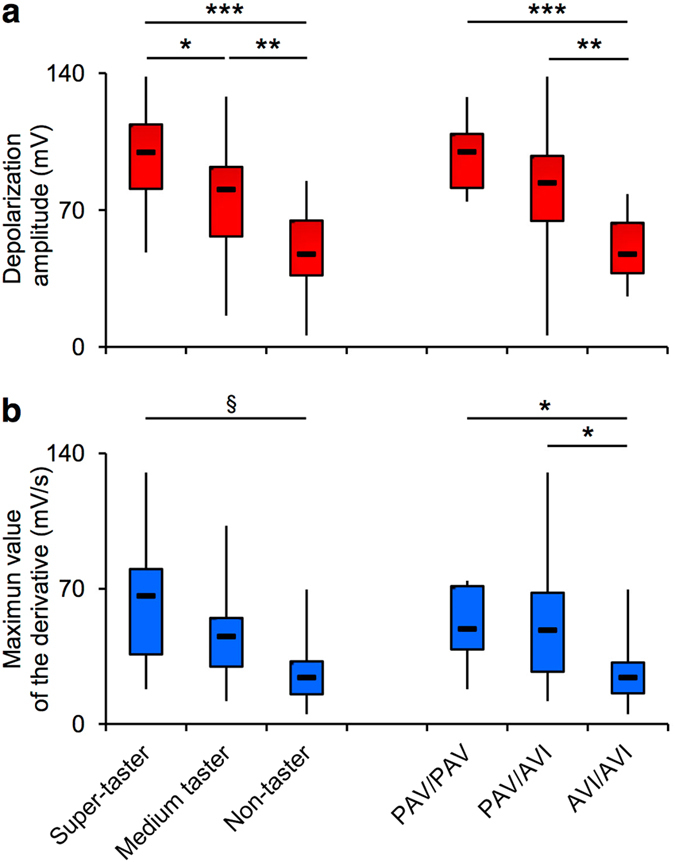
Relationship between the parameters describing the waveform of signals and the PROP taster status or TAS2R38 polymorphisms.The box-and-whisker plots show the minimum, first quartile, median, third quartile, and maximum of each set of data. (a) Depolarization amplitude values. (b) The maximum value of the first derivative values. One-way ANOVA was used to analyze the effects of PROP taster status or TAS2R38 polymorphism on depolarization amplitude and the maximum value of the first derivative (F2,40 > 3.699; P < 0.033). n = 15 super-tasters, n = 15 medium tasters and n = 13 non-tasters; n = 7 individuals with genotypes PAV/PAV in TAS2R38 locus, n = 25 PAV/AVI genotypes and n = 11 AVI/AVI genotypes. *P < 0.05, **P < 0.01, ***P < 0.001 determined by the Newman-Keuls post hoc test; §P < 0.001 determined with Duncan’s test since the assumption of homogeneity of variance was violated.